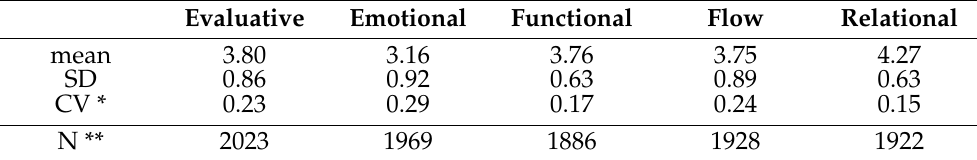
Table 2. Mental wellbeing dimensions.